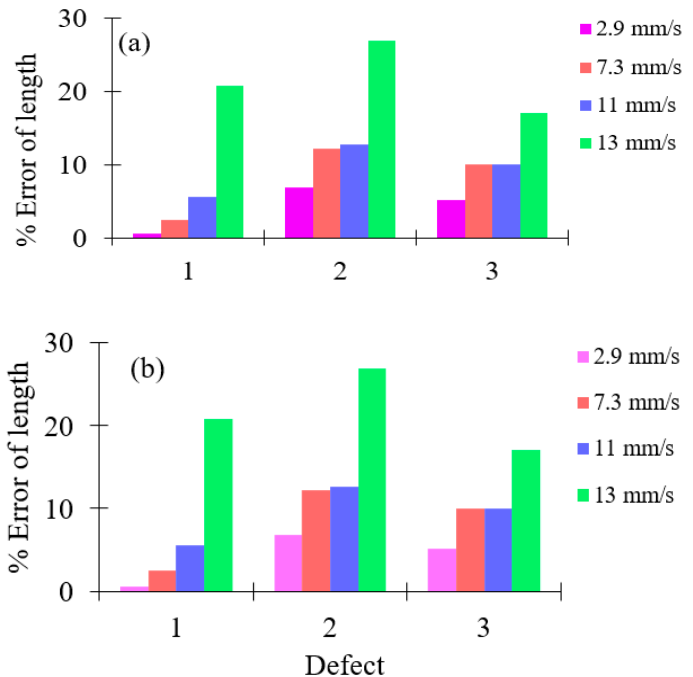
Figure 11. Percentage of error length at different inspection speeds for the different lift-offs; ( a ) 20-mm lift-off and, ( b ) 30-mm lift-off. Table 5. Percentage error for 20-mm and 30-mm lift-off.